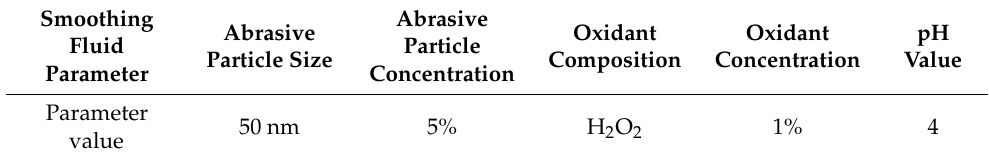
Table 2. Composition parameters of the smoothing